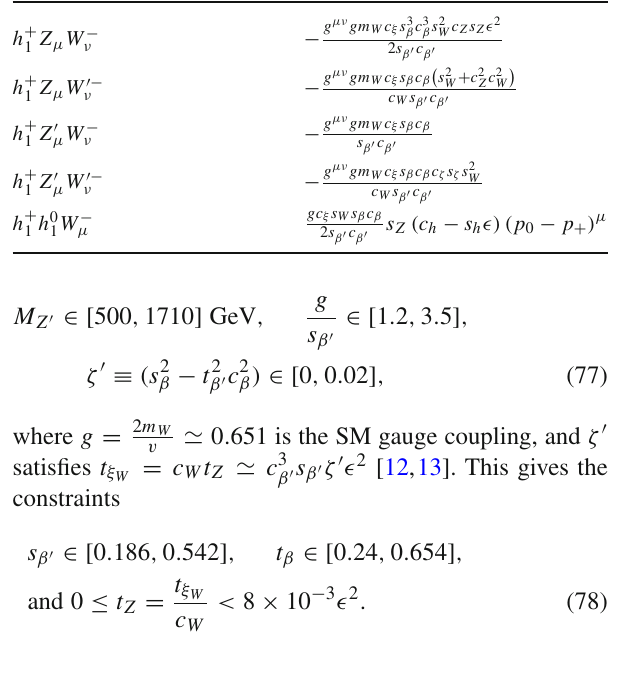
Table 5 Couplings of h + and p 0 , respectively Vertex